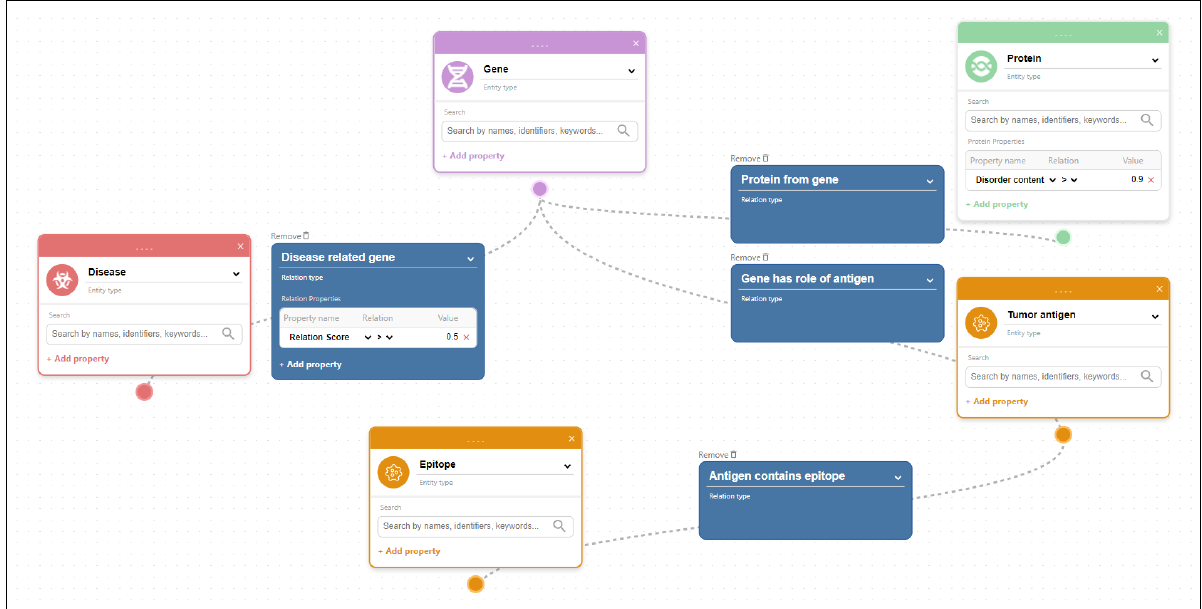
Figure 6. Example of a graphical query drawn using BioGraph Web interface. The data are fetched from imported metadata from the currently supported data sources. The query attempts to find links between Diseases and Genes with a DisGeNET [20] relation score of 0.5 and greater, where genes are transcribed into proteins dataset, with disorder content of 0.9 or higher and genes are also tumor antigens. Protein metadata come from the DisProt [19] dataset, gene metadata come from the HGNC [23] dataset, and disease metadata come from [20] dataset. Epitopes, from Tantigen 2.0 [21] and IEDB [22] are also fetched for the matched tumor antigens. The query pattern matches the structure of the example shown in Figure